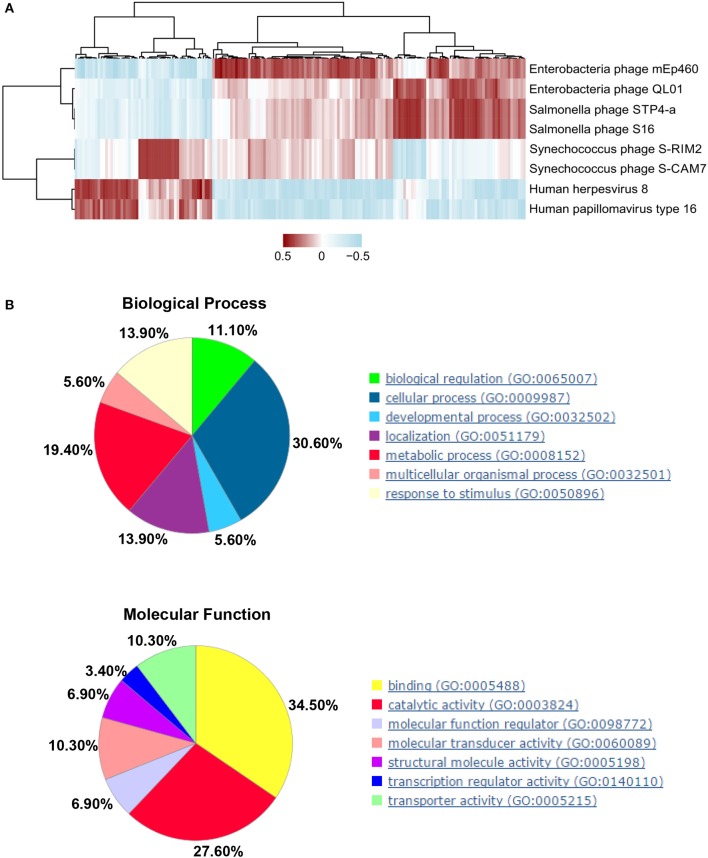
Interactions between significant differentially expressed genes (DEGs) in human host and candidate peripheral blood mononuclear cell (PBMC) virus markers in systemic lupus erythematosus (SLE). (A) Correlations between significant human DEGs and candidate viral markers between health control (HCs) and SLE subjects, as determined by Spearman's statistics (P < 0.05) and correlation coefficient (≥ |0.6|), were selected for the visualizations. Clustered heatmap used the complete method with correlation showing the strength of correlations. (B) Gene Ontology (GO) analysis: biological processes (upper panel) and molecular function (lower panel).